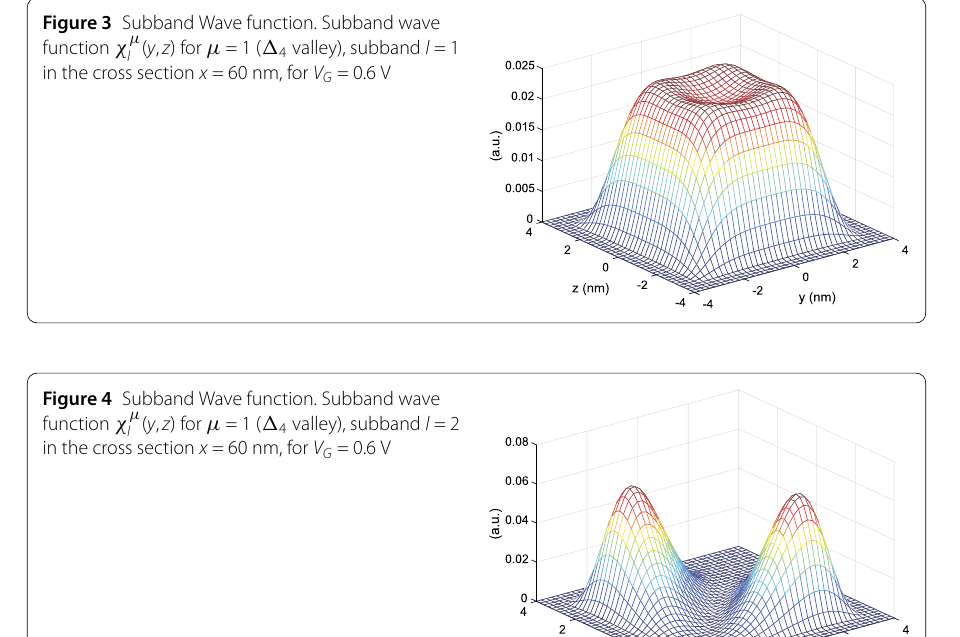
Figure 3 Subband Wave function. Subband wave function χ μ